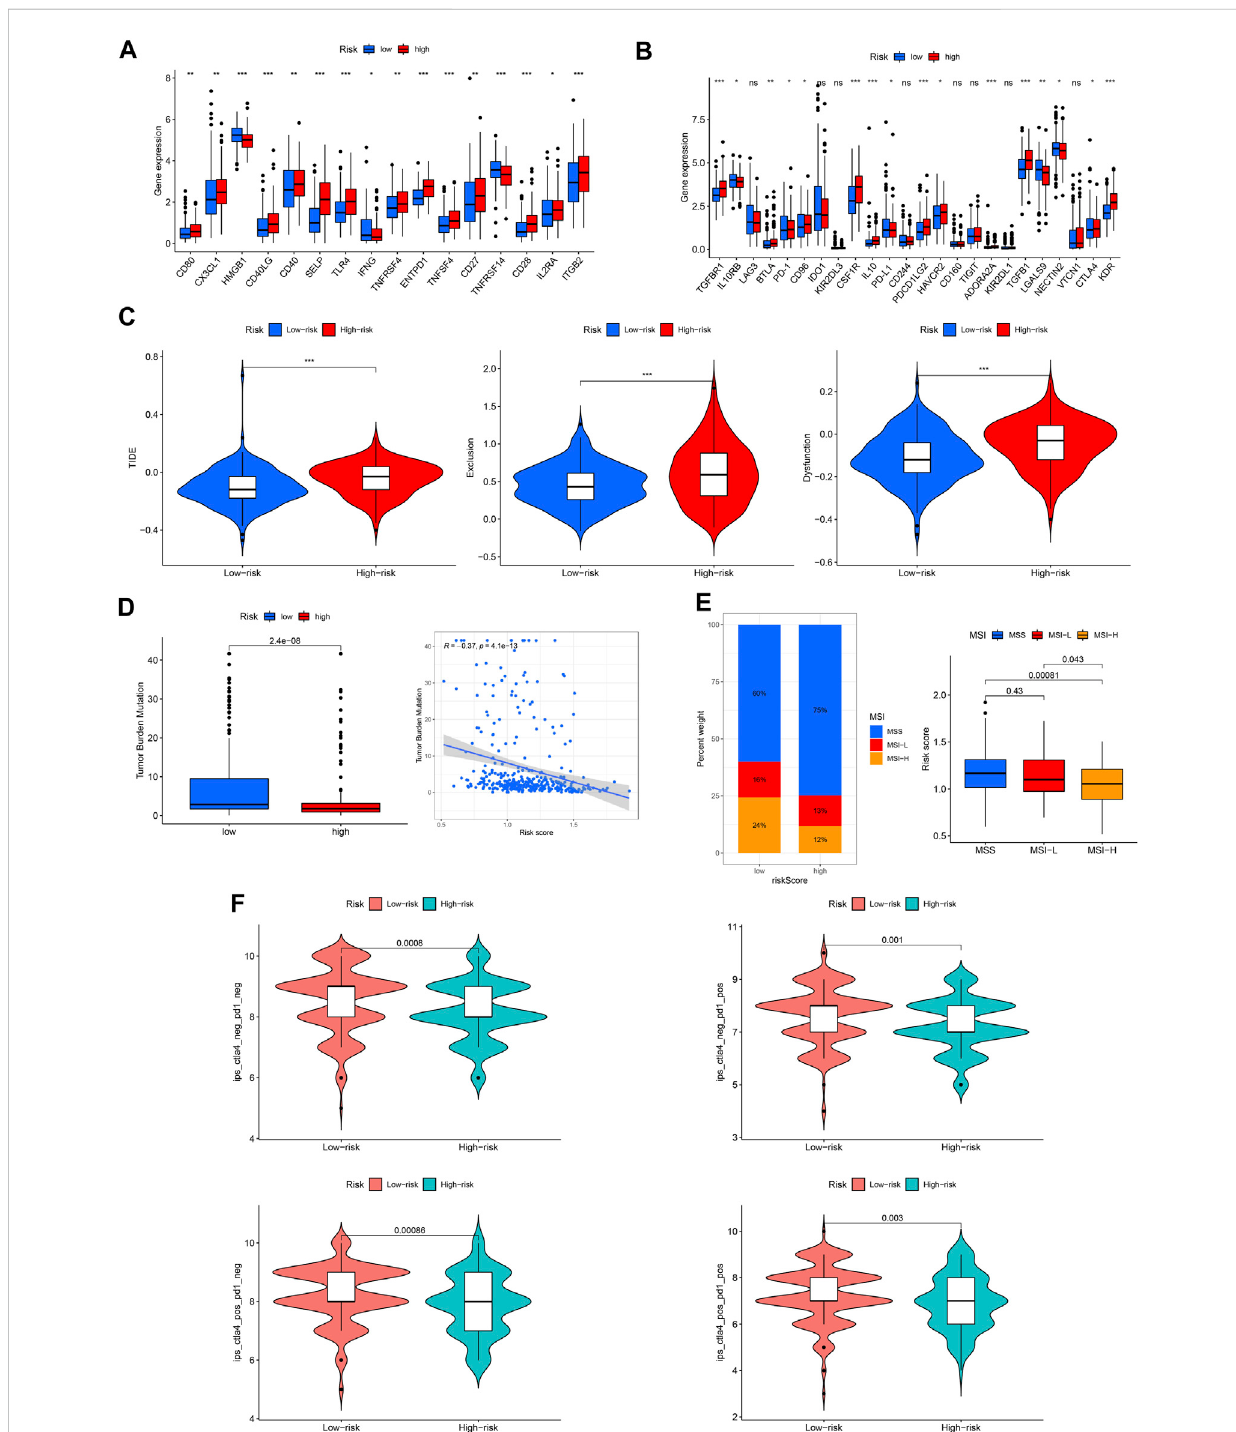
FIGURE 11 Capacity ofimmunotherapyresponseoftheROS-relatedsignature. (A,B) Expression differenceofimmunecheckpointindifferentriskGC. (C) TIDE score. (D) TMB score. (E) MSI of low- and high-risk GC. (F) IPS of low- and high-risk GC in different